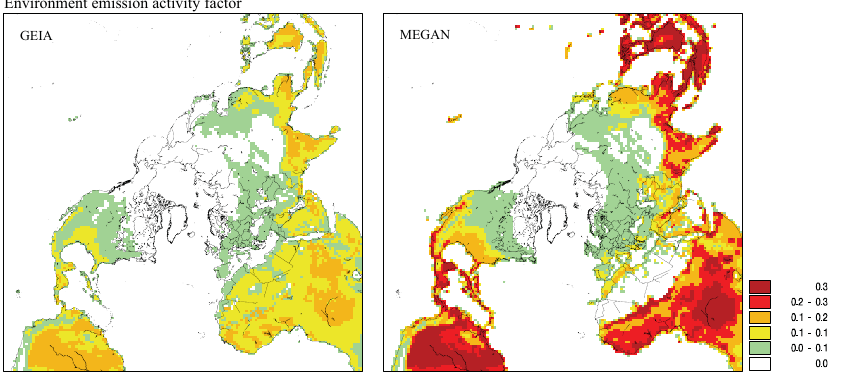
Fig. 5. Non-dimensional environment emission activity factor, calculated for each grid cell based on the equations described by Guenther et al. (1995, 2006) for GEIA and MEGAN models, respectively.